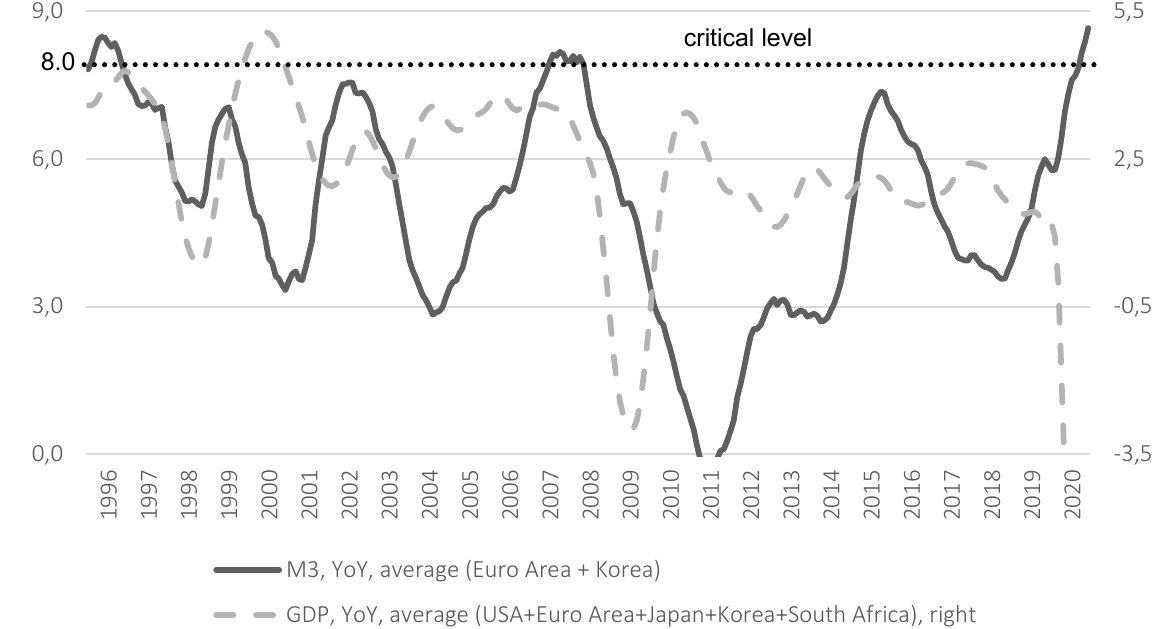
Figure 3. Testing the critical level of money supply